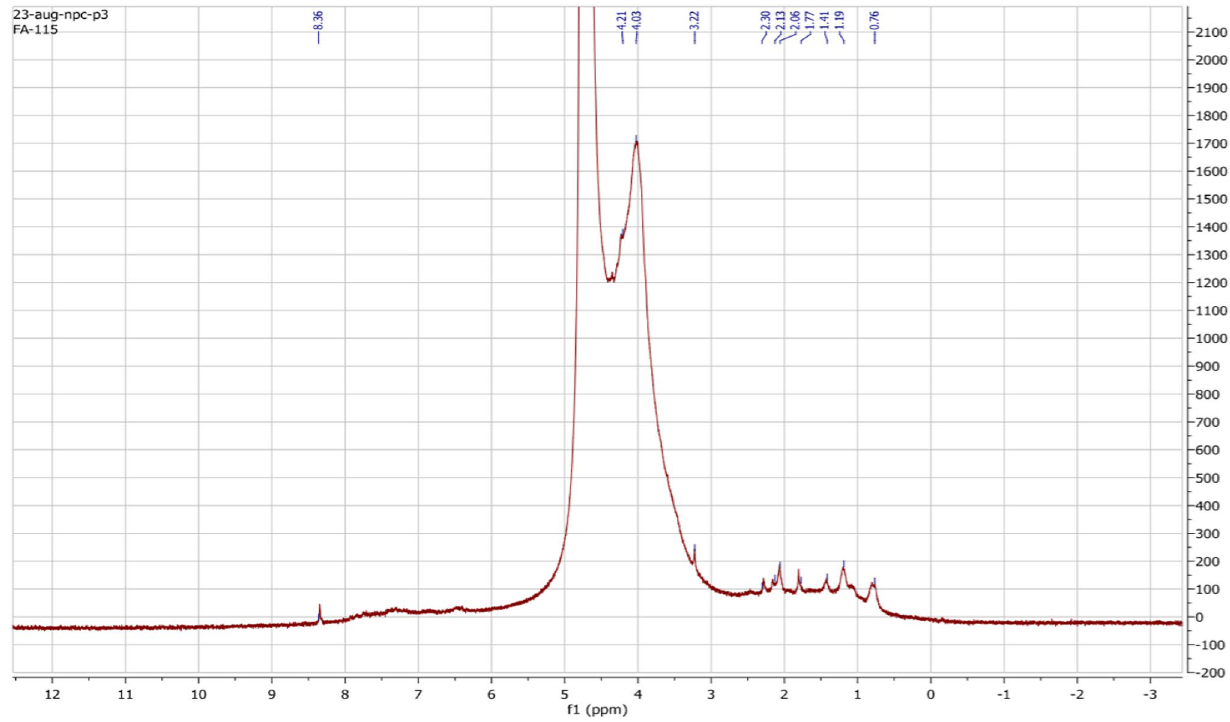
Fig. 2 H 1 -NMR spectrum of aquatic fulvic acid of Lake Mansar